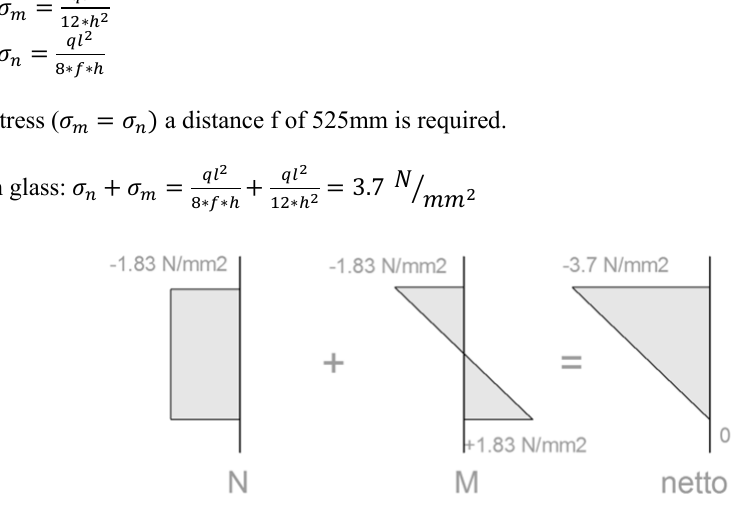
Fig. 6 Stress diagrams for the trussed